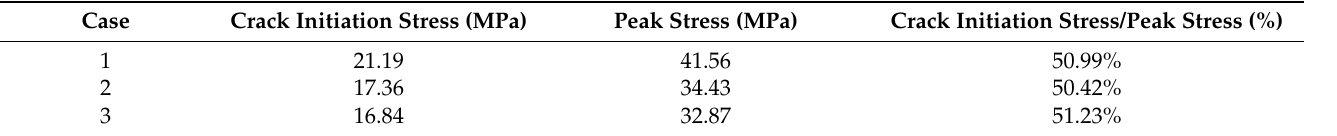
Table 3. Crack initiation stress and peak stress of the three